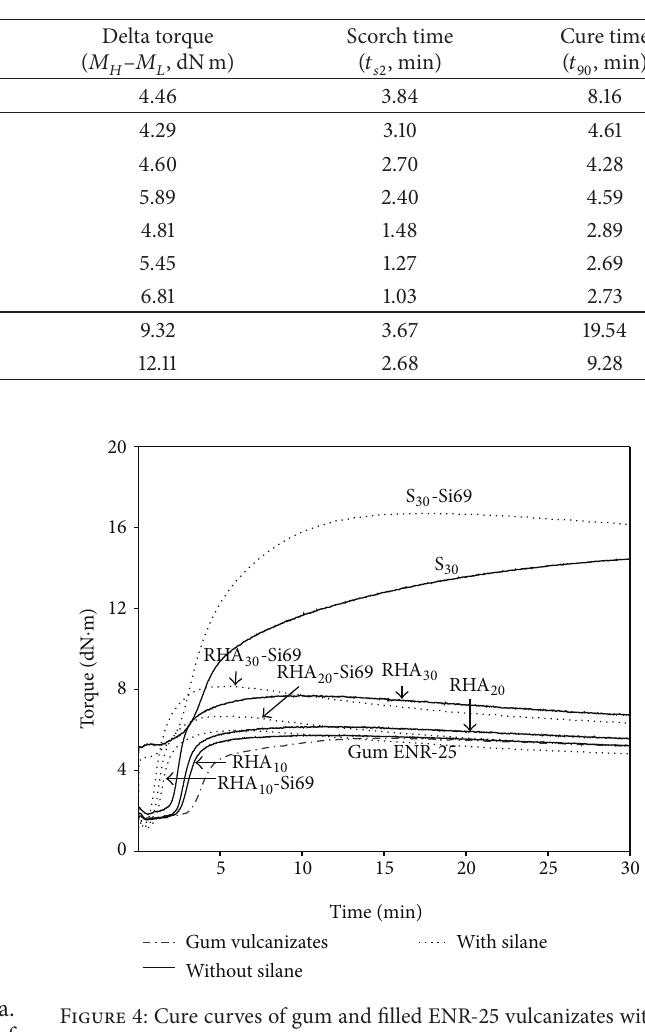
Table 4: Cure characteristics of gum and filled ENR-25 vulcanizates with various RHA contents or 30 phr of silica, with and without silane coupling agent (Si69).